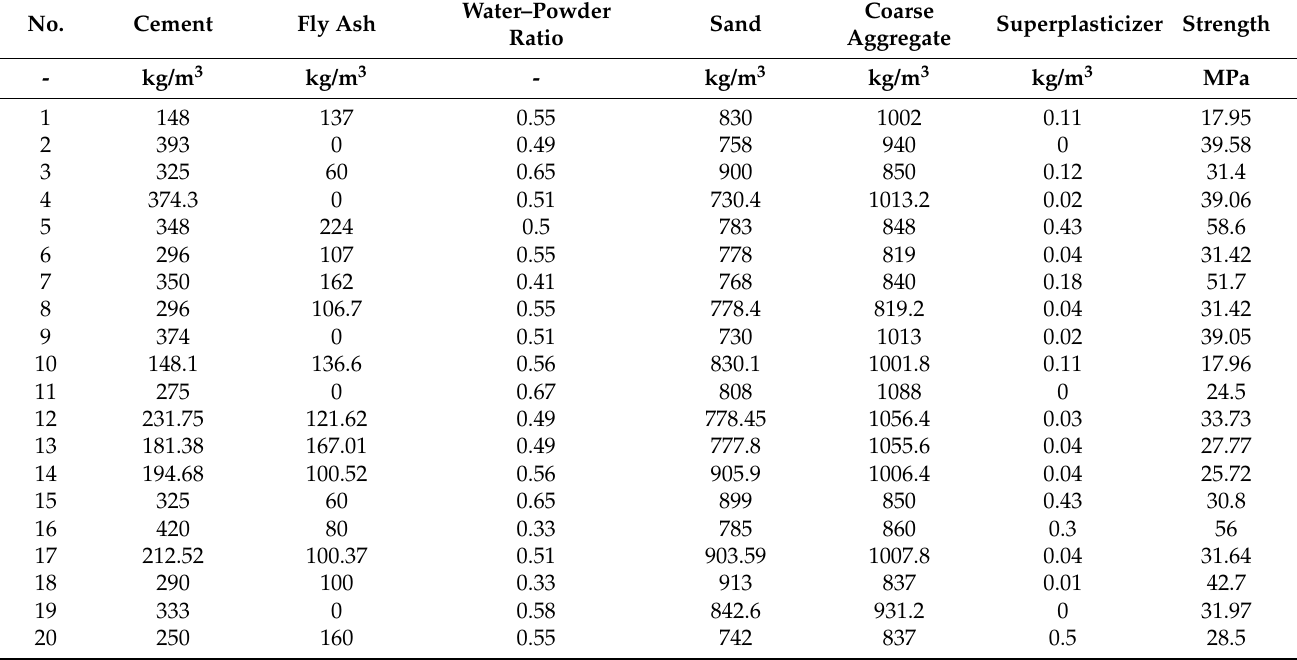
Table A1. Self-compacting concrete mixture components and compressive